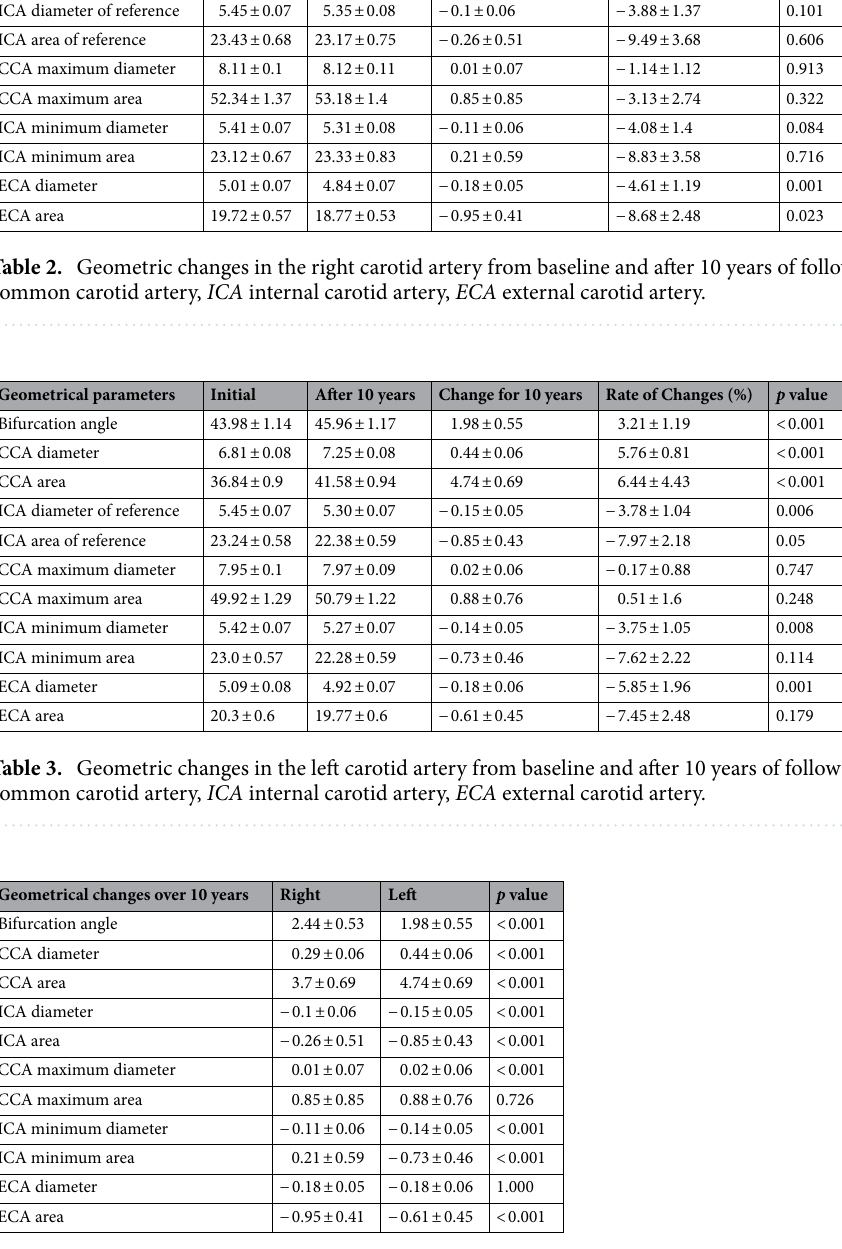
Table 4. Geometric changes in both carotid arteries after a 10-year follow-up period. CCA common carotid artery, ICA internal carotid artery, ECA external carotid